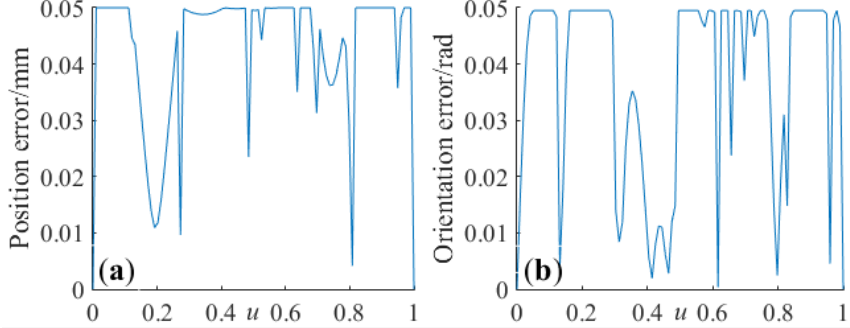
Figure 10. Fitting error of tool-tip position and tool orientation—( a ) Tool-tip position. ( b ) Tool orientation.